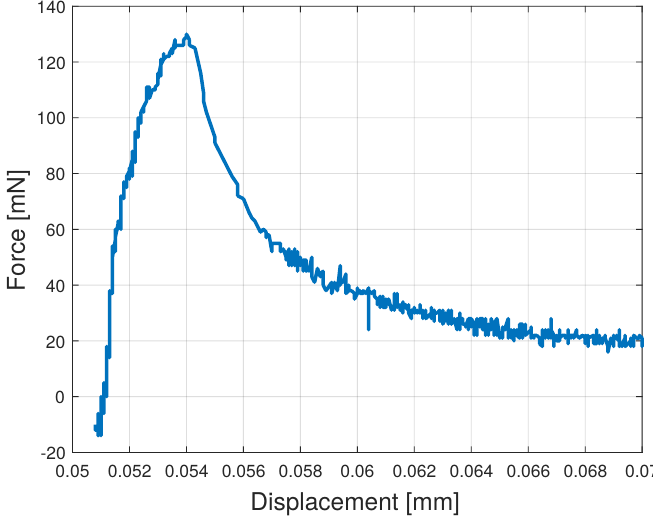
Figure 10. Breakout Force measured during the tensile test at 170